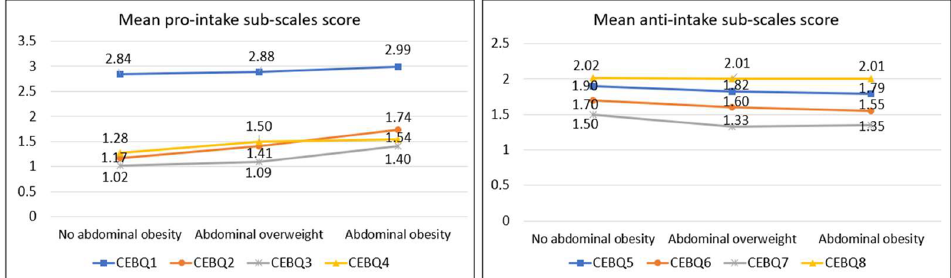
Figure 2. Mean scores of the pro-intake and anti-intake dimensions according to waist-to-height ratio (WHtR) categories [32]. Contrast of means using the H-Kruskal Wallis test; p -value CEBQ1 = 0.282; p -value CBQ2 < 0.001; p -value CBQ3 = 0.048; p -value CBQ4 = 0.030; p -value CEBQ5 = 0.259; p -value CEBQ6 = 0.051; p -value CEBQ7 = 0.276; p -value CEBQ8 = 0.557.